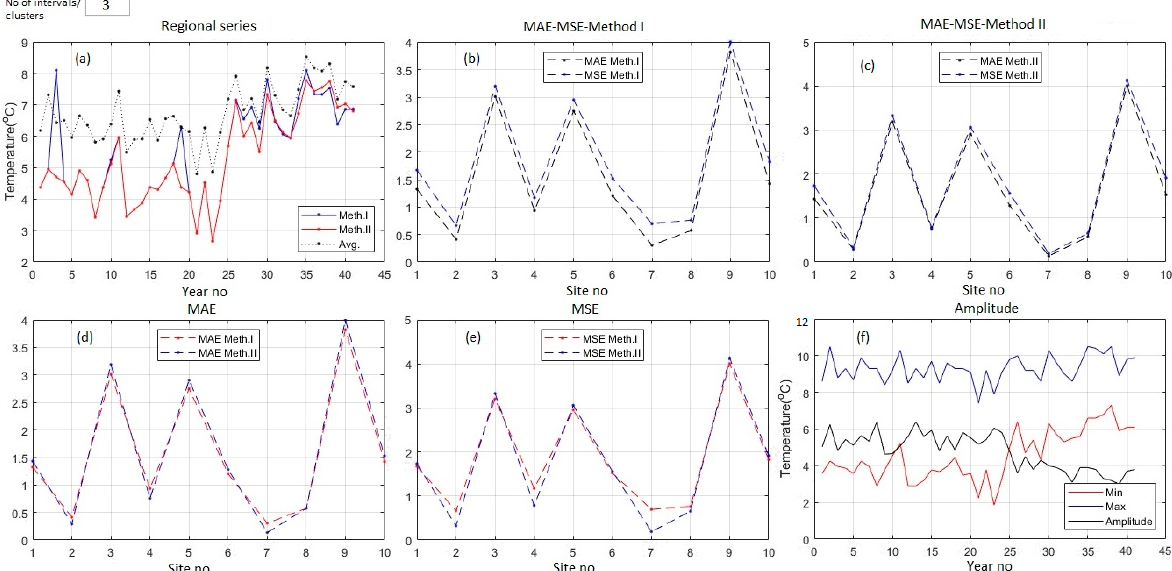
Figure 5. The case of three intervals/clusters for the series of minimum temperatures: ( a ) ‘Regional series’; ( b ) MAE and MSE—Method I; ( c ) MAE and MSE—Method II; ( d ) comparisons of MAEs; ( e ) comparisons of MSEs; ( f ) min, max, and amplitude of the minimum temperature series.